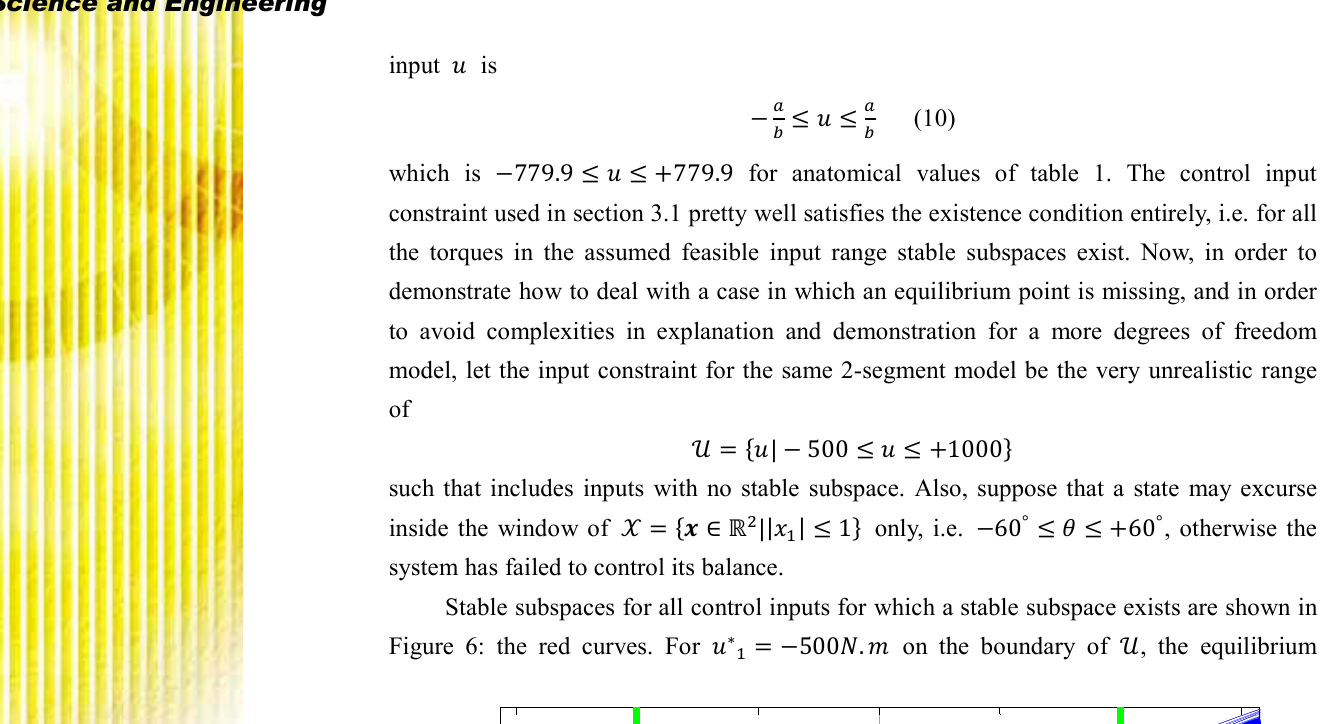
(cid:3404) (cid:3398)500(cid:1840). (cid:1865) on the boundary of (cid:2287) , the equilibrium (cid:2869)